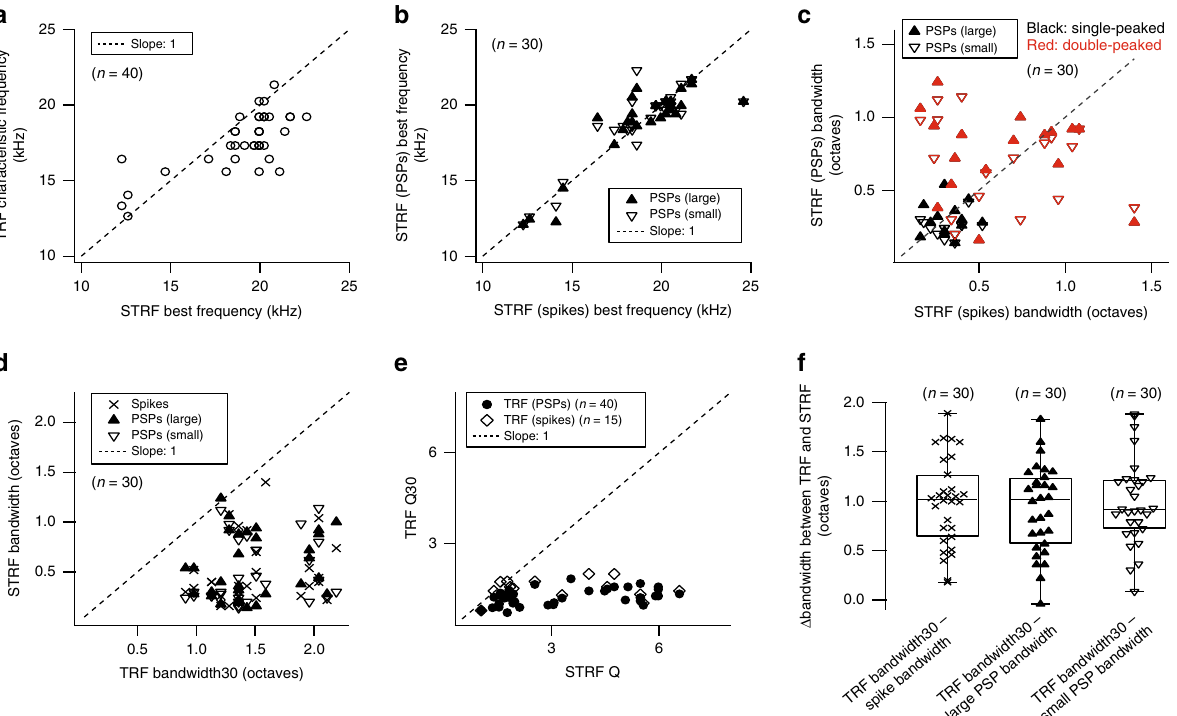
Fig. 5 Bandwidth comparison between TRFs and STRFs. a Relationship between TRF characteristic frequencies and STRF best frequencies derived from all events ( n = 40/66 neurons with paired recordings for both, pure tones and DMR stimuli; Pearson ’ s r = 0.73, p = 10 − 7 ). b Relationship between spike- based STRF best frequencies and PSP-based STRF best frequencies ( n = 30/40 neurons with signi fi cant STRF sub fi elds for spiking, large PSP, and small PSP events; large PSPs (closed triangles), small PSPs (open triangles)). c Relationship between spike-based STRF bandwidths and PSP-based STRF bandwidths ( n = 30/40 neurons with signi fi cant STRF sub fi elds for spiking, large PSP, and small PSP events; large PSPs (closed triangles), small PSPs (open triangles); single-peaked STRFs (black), double-peaked STRFs (red) for spikes, or large PSPs, or small PSPs). Note that red color indicates the presence of a second peak in small PSP-, or large PSP-, or spike-based STRFs. d Relationship between STRF bandwidths and TRF bandwidth30s ( n = 30/40 neurons with signi fi cant STRF sub fi elds for spiking, large PSP, and small PSP events). e Relationship between TRF Q30s and STRF Qs. The black closed circles indicate the relationship between PSP-based TRF Q30s and STRF Qs derived from all events ( n = 40/66 neurons with paired recordings for both, pure tones and DMR stimuli; two-tailed paired Student ’ s t -test, p = 10 − 9 ). Open squares indicate the relationship between spike-based TRF Q30s (normalized-driven ratio ≥ 0.3) and STRF Qs derived from all events ( n = 15/40 neurons with paired recordings for TRFs (normalized-driven ratio ≥ 0.3) and STRFs; two-tailed paired Student ’ s t -test, p = 0.0025). f Bandwidth differences ( Δ bandwidth) between PSP-based TRFs and STRFs. Δ bandwidths (mean ± s.d., n = 30/40 neurons with signi fi cant STRF sub fi elds for spiking, large PSP, and small PSP events) were 0.99 ± 0.45 octaves (for spikes), 0.92 ± 0.44 octaves (for large PSPs), and 0.99 ± 0.44 octaves (for small PSPs). The median Δ bandwidth values, the middle line between hinges, were 1.02 for spikes, 1.01 for large PSPs, and 0.91 for small PSPs. The lower and upper hinges are at the 25th and 75th percentiles. Minimum and maximum values are indicated by